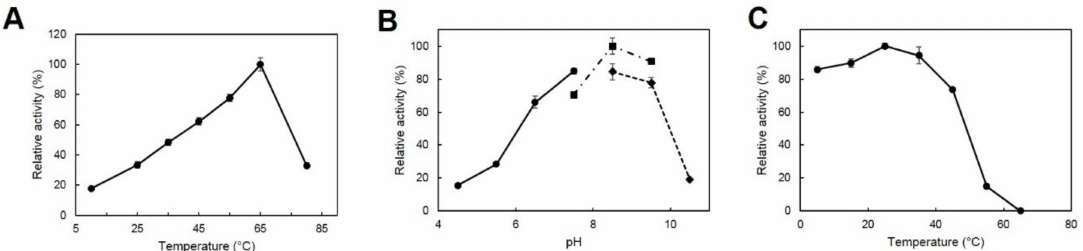
Figure 1. E ff ects of temperature and pH on the enzyme activity of DaMDHAR. ( a ) Enzyme activity was measured at various temperatures as described in the Materials and Methods section. The activity value shown at 65 ◦ C was taken as 100%. ( b ) The e ff ect of pH was studied with a sodium acetate bu ff er (pH 3.5 to 7.5, closed circle), Tris-Cl bu ff er (pH 7.5 to 9.5, closed square), and glycine bu ff er (pH 8.5 to 10.5, closed diamond). ( c ) The thermal stability of DaMDHAR was studied by pre-incubating DaMDHAR at various temperatures for 30 min. After the 30 min pre-incubation, the residual activity of DaMDHAR was calculated by taking the non-heated DaMDHAR activity as